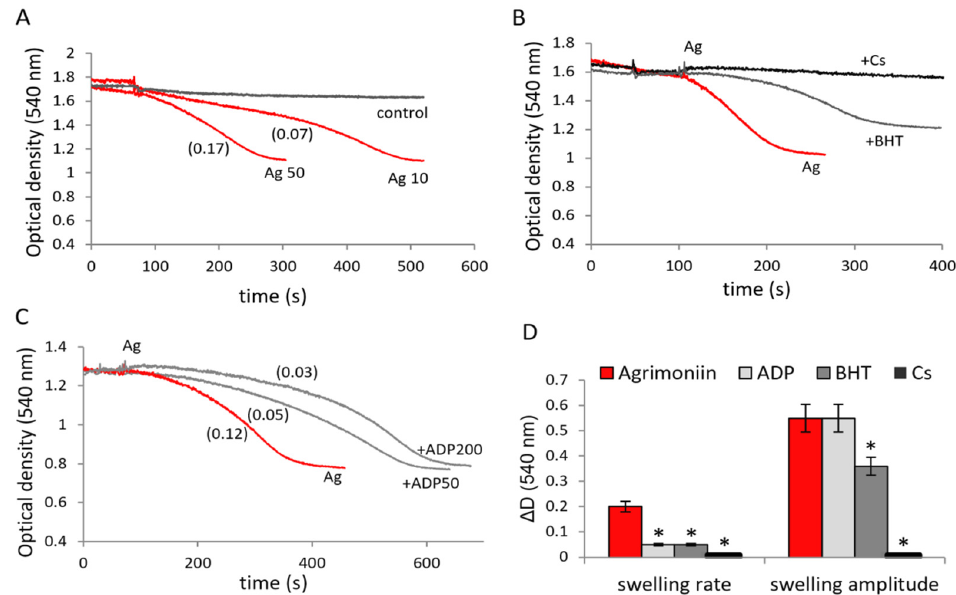
Figure 5. Induction of the mitochondrial swelling by agrimoniin and the influence of MPTP inhibitors. Induction of the swelling of mitochondria by additions of 10 µM and 50 µM agrimoniin ( A ); the influence of butyl-hydroxytoluene (BHT, 10 µM), cyclosporine A (Cs, 2 µM) ( B ) and ADP (50 and 200 µM) ( C ) on the induction of swelling by agrimoniin; D influence of inhibitors on the rate and amplitude of the swelling induced by agrimoniin ( D ). Swelling rates ( Δ D/min) are indicated in parentheses. Asterisk (*) indicates values that differ significantly from the control values ( p < 0.05).